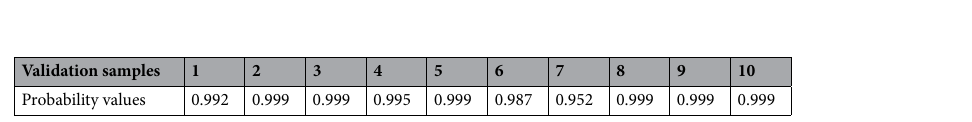
Figure 5. Locational probability map of beacon sites in the Wenzhou area (generated by the authors using ArcGIS 10.3.1).